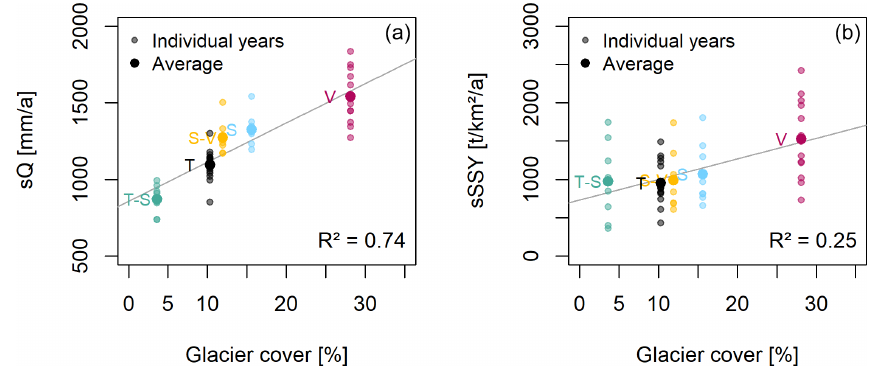
Figure 4. Annual specific discharge (a) and annual specific suspended sediment yields (b) vs. glacier cover (glacier inventory 4, 2015; Buckel and Otto, 2018) in the sub-catchments.